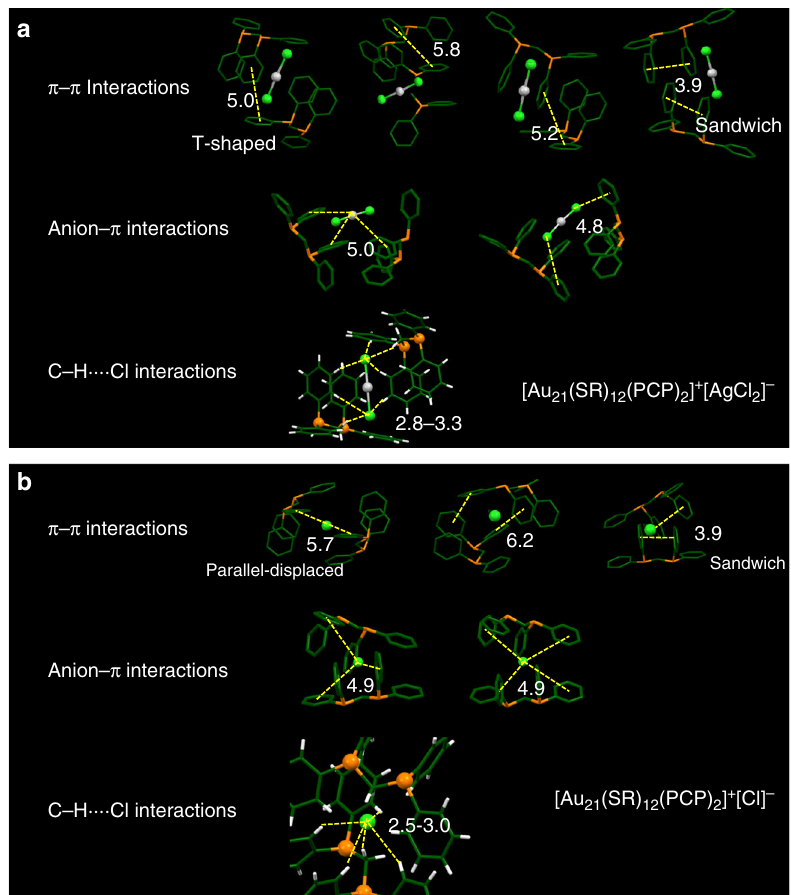
Fig. 5 Anatomy of the interactions of surface hooks. Illustration of the interparticle π – π , anion – π , and C-H··Cl interactions for a [Au 21 (SR) 12 (PCP) 2 ] + [AgCl 2 ] − and b [Au 21 (SR) 12 (PCP) 2 ] + [Cl] − . Gray = Ag, yellow = S, orange = P, green = C, light green = Cl, white = H. The yellow dashed lines correspond to the measured